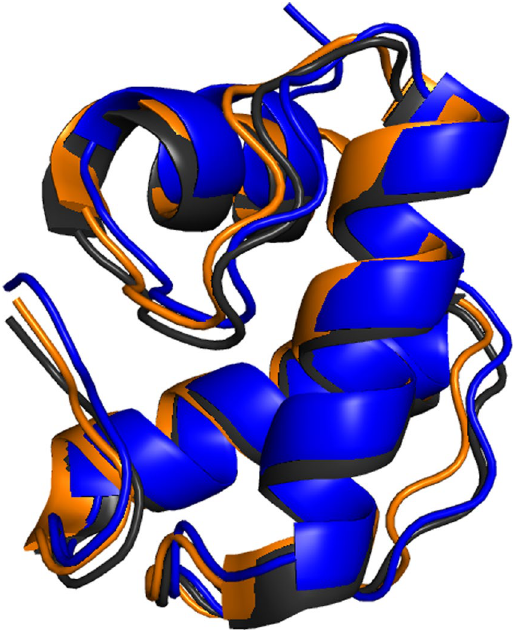
Figure 2. Structural alignment of CBD domains of AP3gp15 (blue), phage phiKZ endolysin (orange) and Zn- dependent amidase from C . acetobutylicum (grey) highlights a strong conservancy of three antiparallel helices bundle